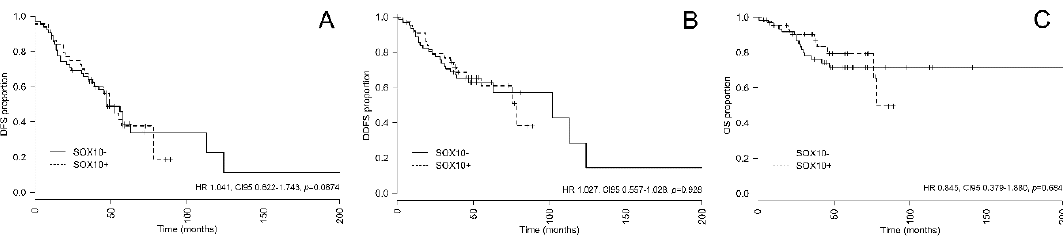
Figure 2. Survival analysis with regard to SOX-10 status. The figure shows Kaplan–Meier curves for ( A ) disease-free survival (DFS), ( B ) distant disease-free survival (DDFS), and ( C ) overall survival (OS) for SOX-10-positive and -negative patients. HR, Hazard ratio; CI, confidence interval; SOX-10, SRY-related HMG-box 10.